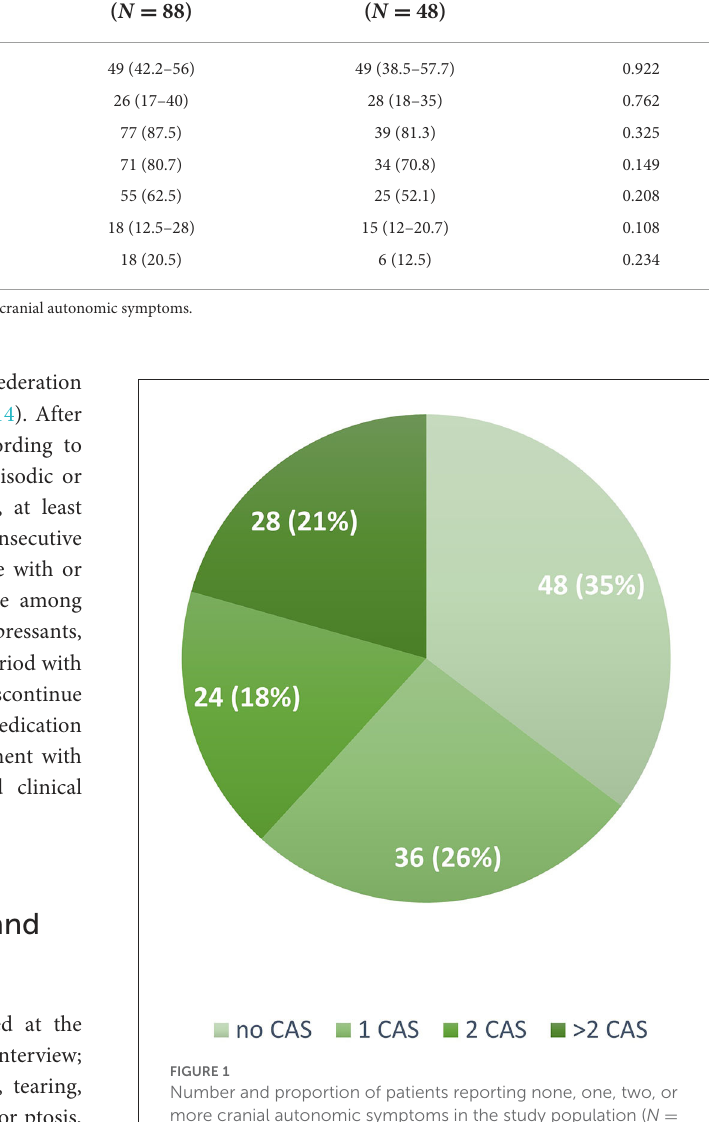
TABLE 1 Characteristics of the overall study population and the subgroups: patients with and without cranial autonomic symptoms. Baseline characteristics